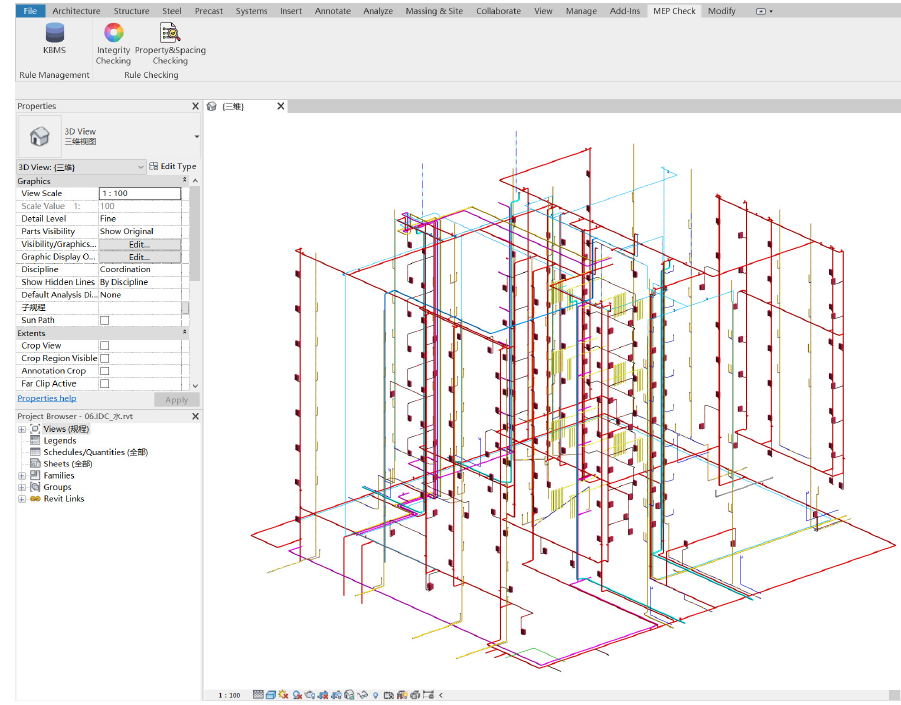
Figure 12. The BIM model and the MEP check tab.